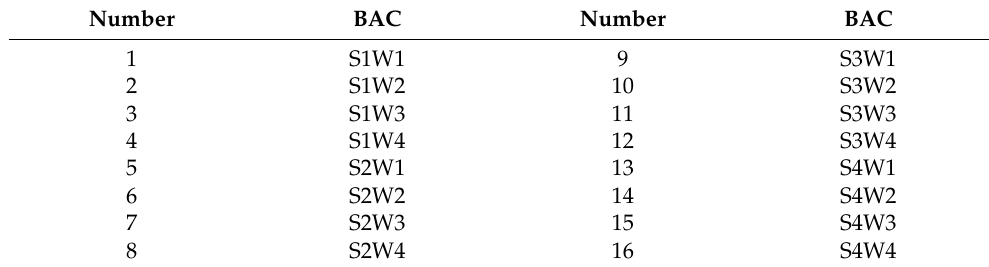
Table 2. Basic action concept